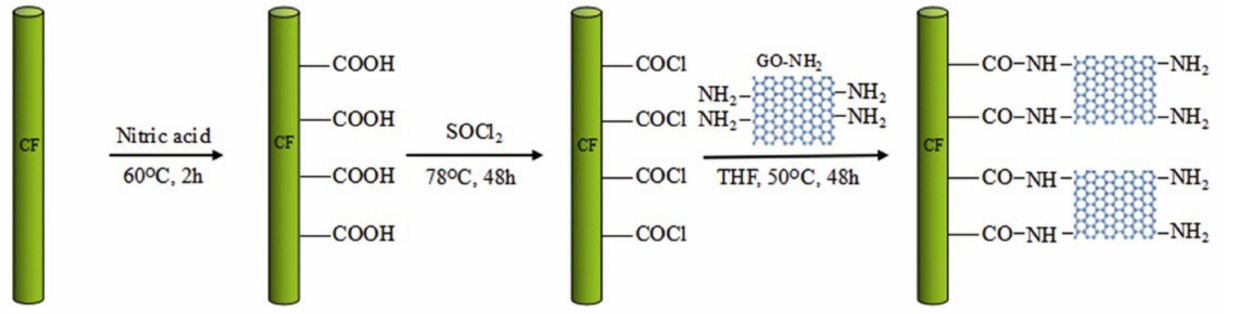
Figure 1. Schematic procedure of CF treatment [38]. Reproduced with permission from Materials & Design; published by Elsevier,